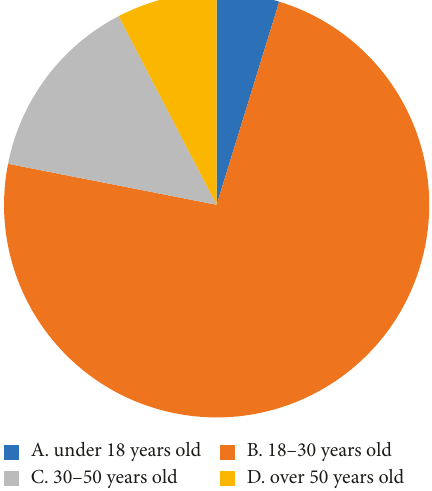
Figure 5: Age distribution of respondents.